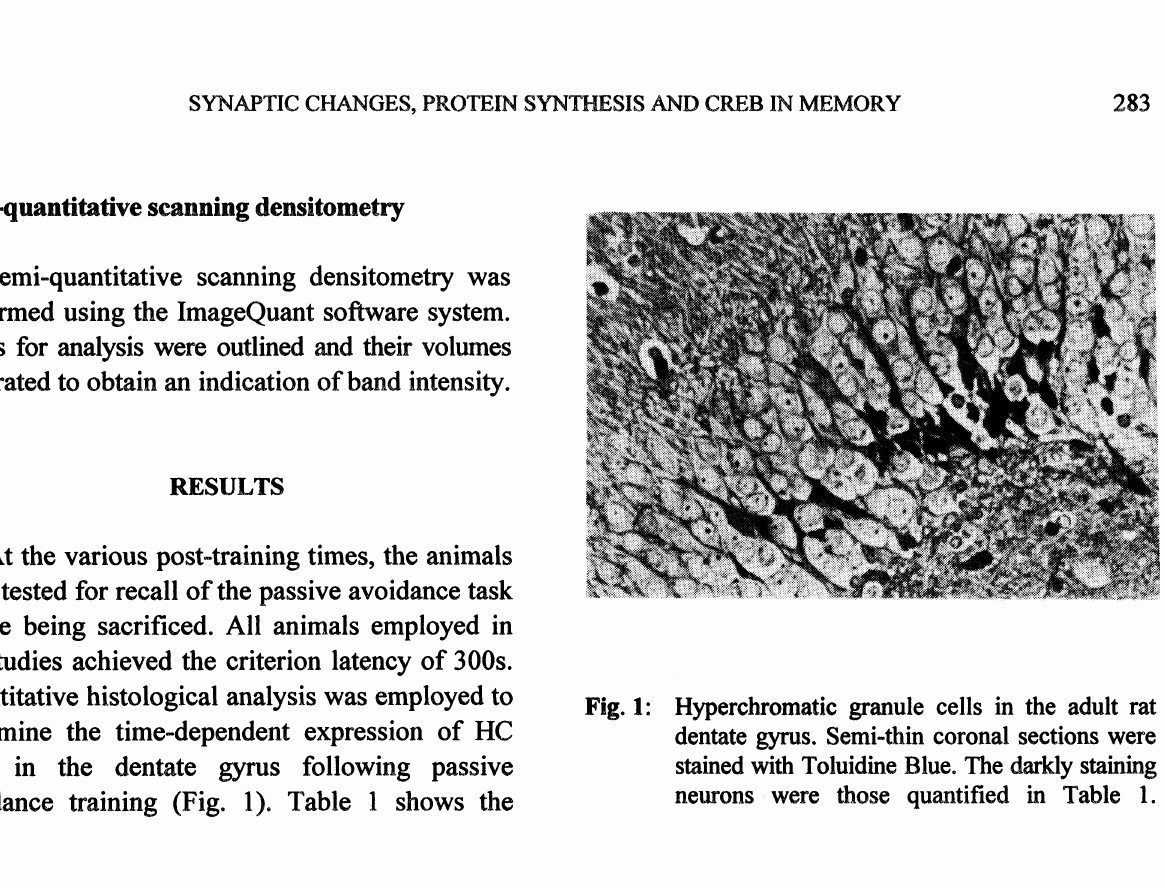
Distribution of hyperchromatic cells in the dentate gyrus of na’fve and trained adult rats following passive avoidance